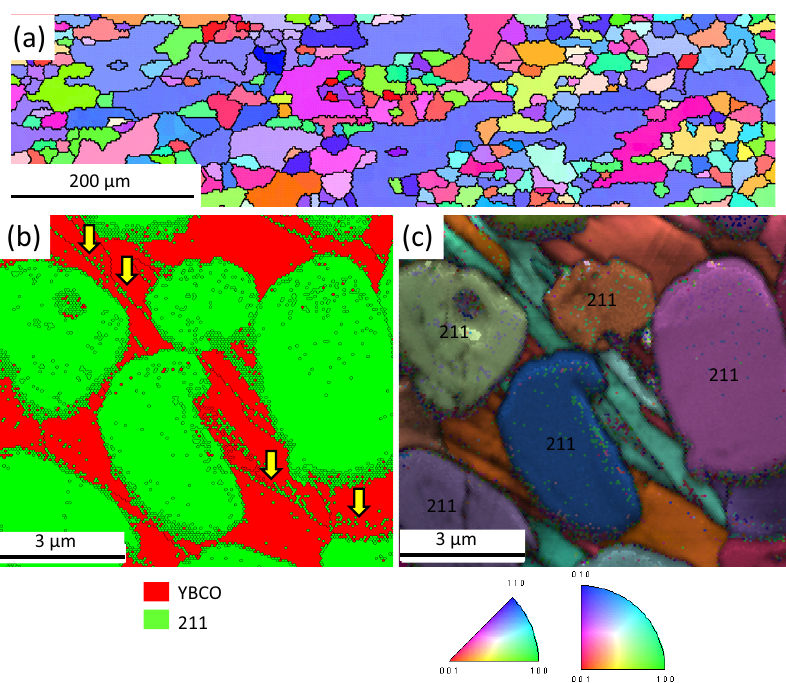
Figure 4. ( a – c ) EBSD orientation imaging of foam strut pieces with mechanically polished surfaces. The scan areas are selected to be entirely inside the struts. ( a ) Overview measurement (scan area ∼ 1 mm × 200 µ m) along a foam strut ligament. Orientations are given perpendicular to the sample surface, i.e., in [001]-direction. The EBSD stepsize for this measurement was 2 µ m. Both phases (YBCO and Y-211) are plotted together. The color code for the orientation mapping is given below image ( c ). ( b ) Phase mapping (red—YBCO, green—Y-211) of a 10 × 10 µ m 2 scan area. Several large and many tiny Y-211 particles are embedded within the YBCO matrix. The EBSD-detected GBs are indicated using thin, black lines. The yellow arrows point to the tiny Y-211 particles found in groove-like structures in the foam strut. ( c ) Inverse pole figure (IPF) map with overlaid image quality (IQ) mapping, recorded with high magnification and an EBSD stepsize of 50 nm. Note here that the YBCO matrix shows orientations up to 60 ◦ off the [001]-orientation which reflects the 3D-orientation of the strut within the bulk foam. The Y-211 particles reveal several different